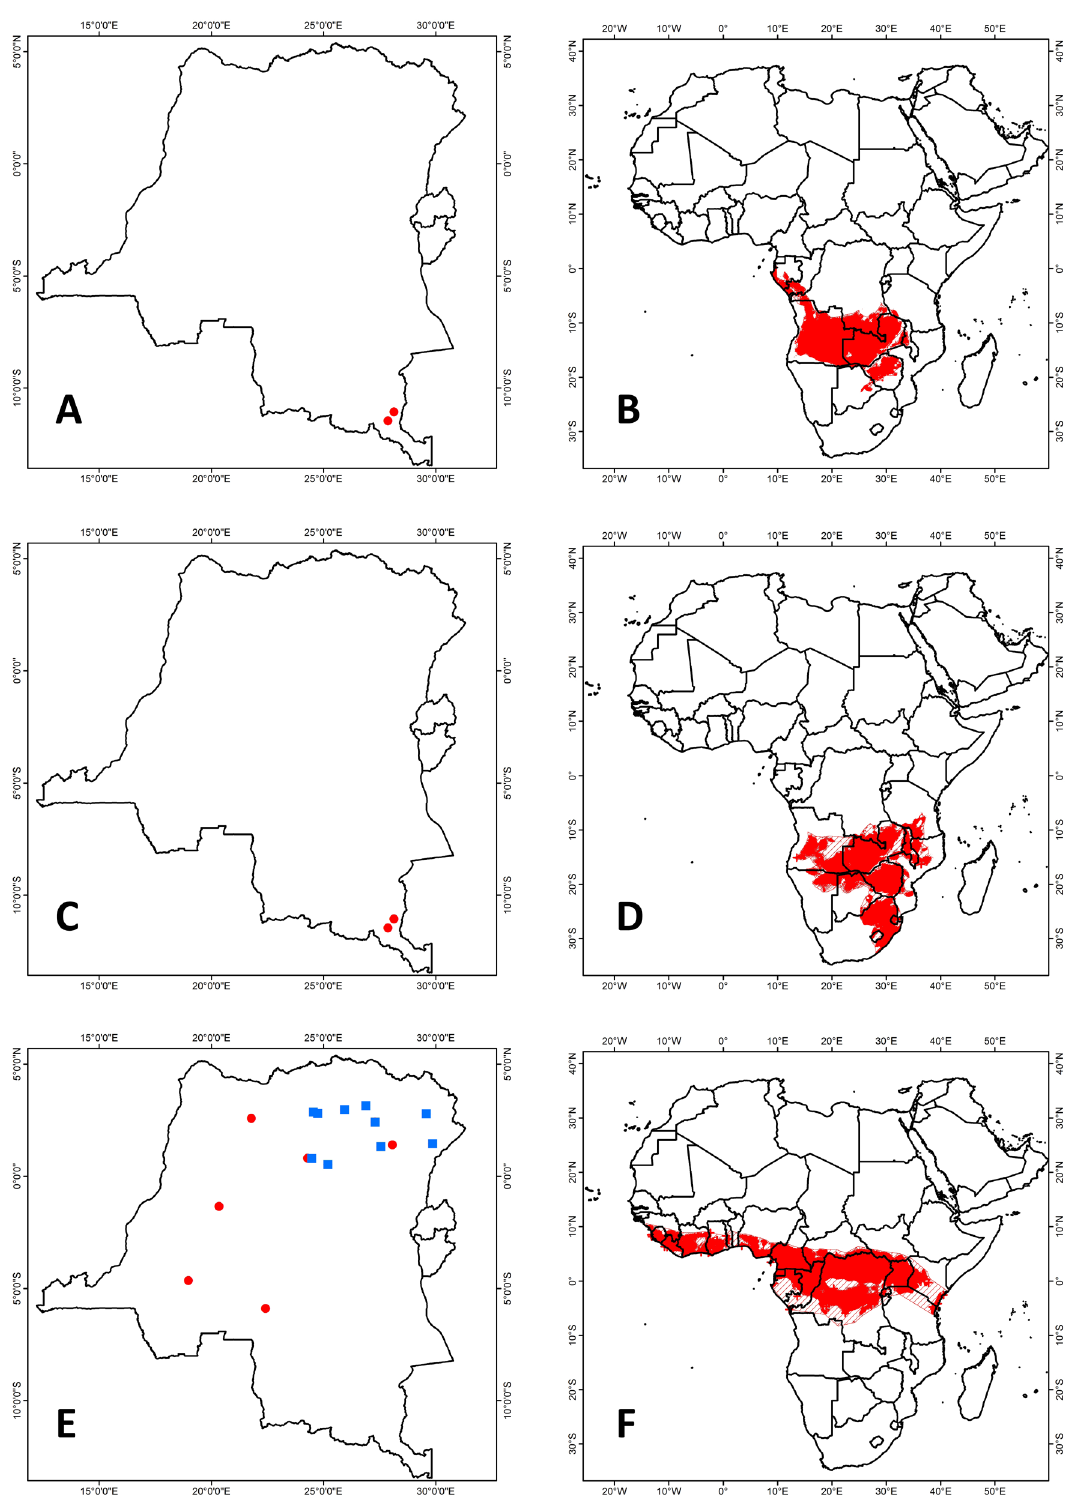
Fig. 42. Distribution maps. A–B . Laephotis angolensis Monard, 1935. C–D . Laephotis